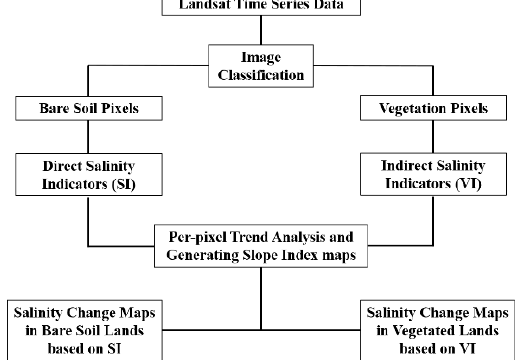
Figure 2. Flowchart of proposed method for trend analysis of soil salinity and mapping salinity